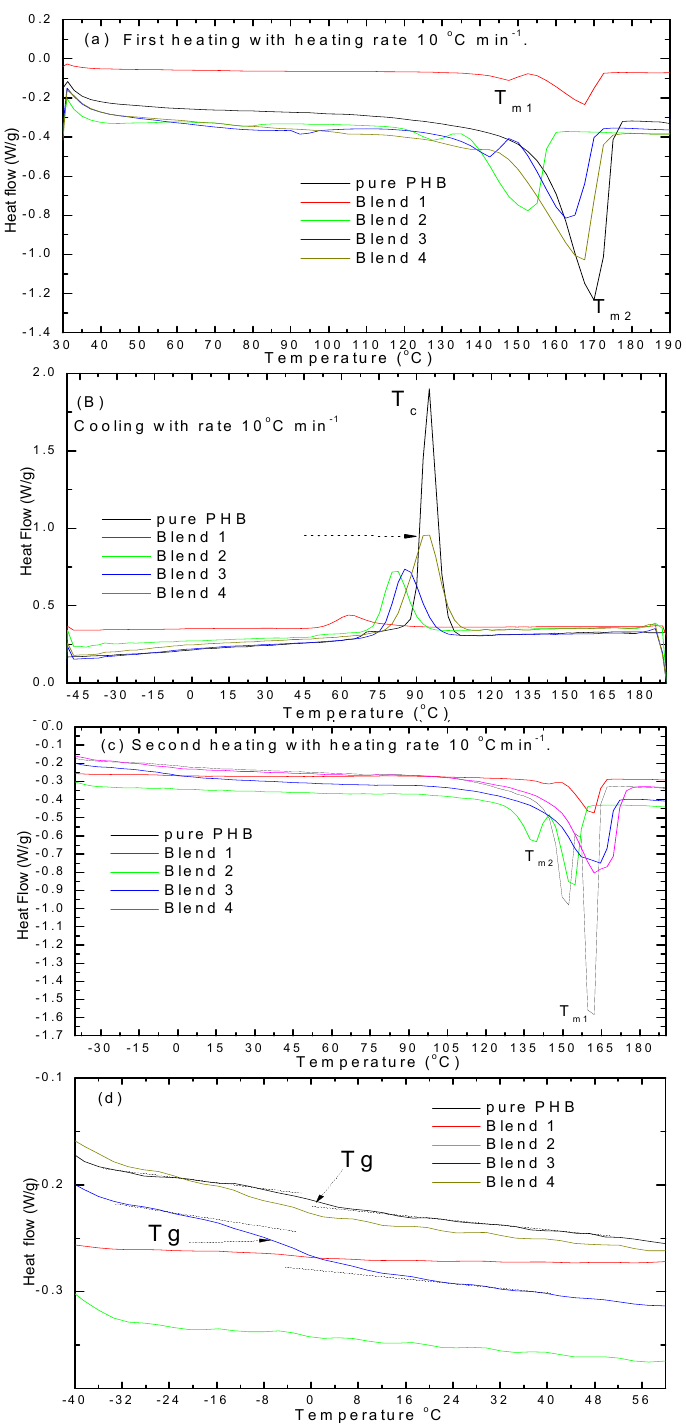
Figure 7. DSC curves for pure PHB and its blends ( a ) first heating; ( b ) cooling; ( c ) second heating; and ( d ) second heating to determine the glass transition temperature region.